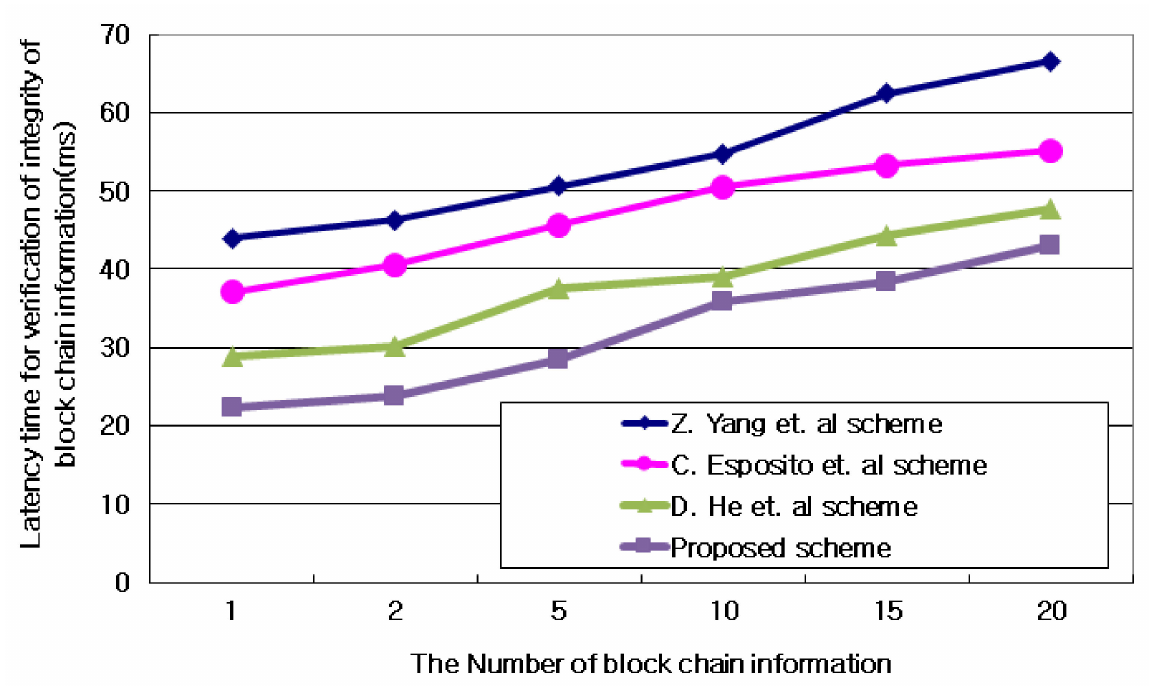
Figure 9. Delay time for verification of the integrity of blockchain information.